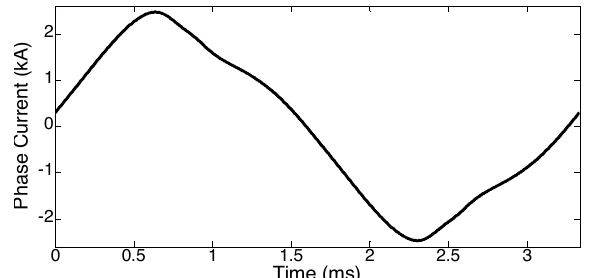
Figure 7: Current waveform of phase 'a'.